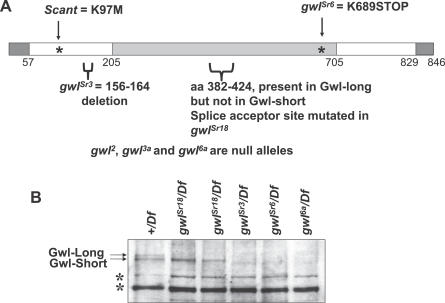

gwl Alleles Generated and Used in This Study(A) Molecular map of gwl alleles. Gwl's highly conserved kinase domain (white) is predicted to be split by a less-conserved intervening sequence of yet unknown function (light gray). The N-terminal and C-terminal ends are also less conserved (dark gray). This diagram is inspired from the one proposed in Yu et al. [13]. The Scant mutation changes lysine residue 97 to methionine, making Gwl hyperactive and altering its specificity in vitro. Mutation Scant revertant 3 (gwlSr3) removes exactly nine codons coding for residues 156–164 predicted to be part of the kinase fold. Mutation Scant revertant 6 (gwlSr6) introduces a premature ochre termination codon instead of lysine 689. Genetically, both mutations gwlSr3 and gwlSr6 seem to have residual Gwl function. Mutation gwlSr18 changes the reading frame following the splice acceptor site at the beginning of exon 4, which encodes residues 382–424 in Gwl-long. Exon 4 is spliced out from Gwl-short and, therefore, Gwl-short is unaffected by the gwlSr18 mutation. Mutations gwl2, gwl3a, and gwl6a are null alleles generated by imprecise excisions of a P-element (see Figure 1C).(B) Anti-Gwl western blot on larval brain extracts of the indicated genotypes. Gwl-long and Gwl-short are both visible in the WT lane (+/Df). Two gwlSr18/Df samples were loaded to confirm that the absence of the top Gwl band is not artifactual.